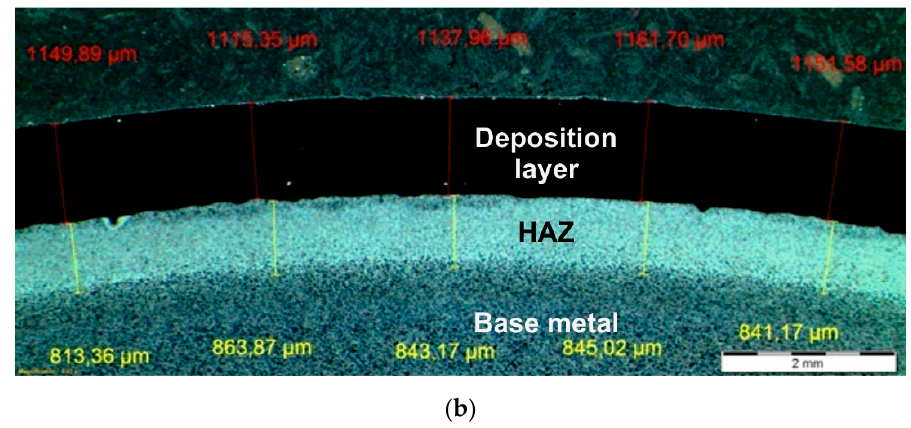
Figure 4. Sample macrostructures of the fusion line between nickel ‐ based superalloy surfaced layer and steel pipe base material ( a ) powder plasma surfacing (sample P2), ( b ) powder laser surfacing (sample L4). Table 8. The average thickness of the surfaced layers, iron content in the coating layers and HAZ width for samples obtained in the process of plasma powder transferred arc surfacing (PPTA), Table 6.